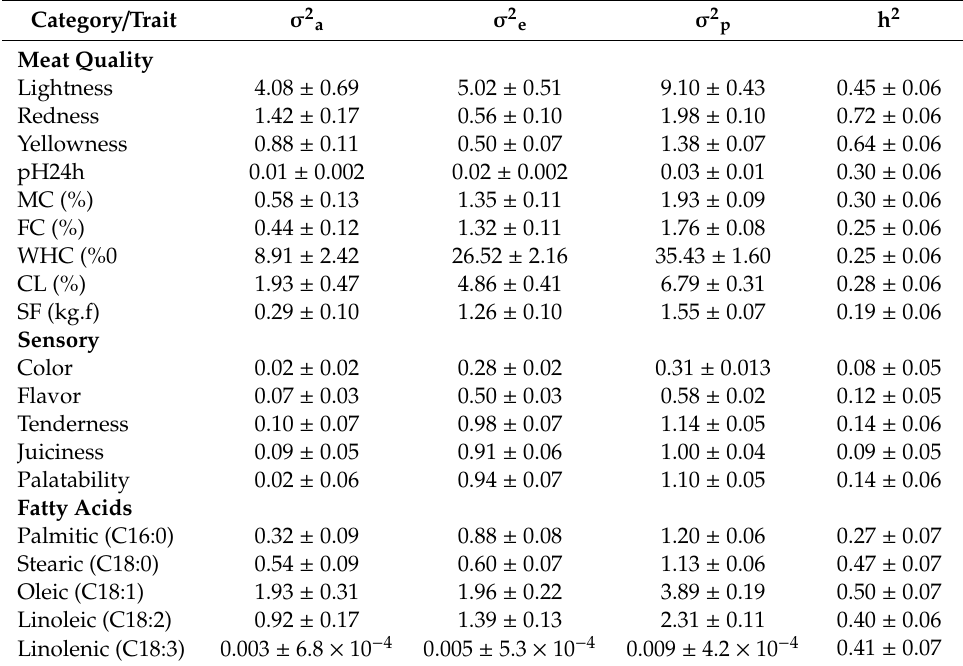
Table 2. Additive genetic variance ( σ 2 a ), residual variance ( σ 2 e ), phenotypic variance ( σ 2 p ), and heritability estimates ( h 2 ) with standard error for meat quality traits, sensory characteristics, and fatty-acid composition of Duroc